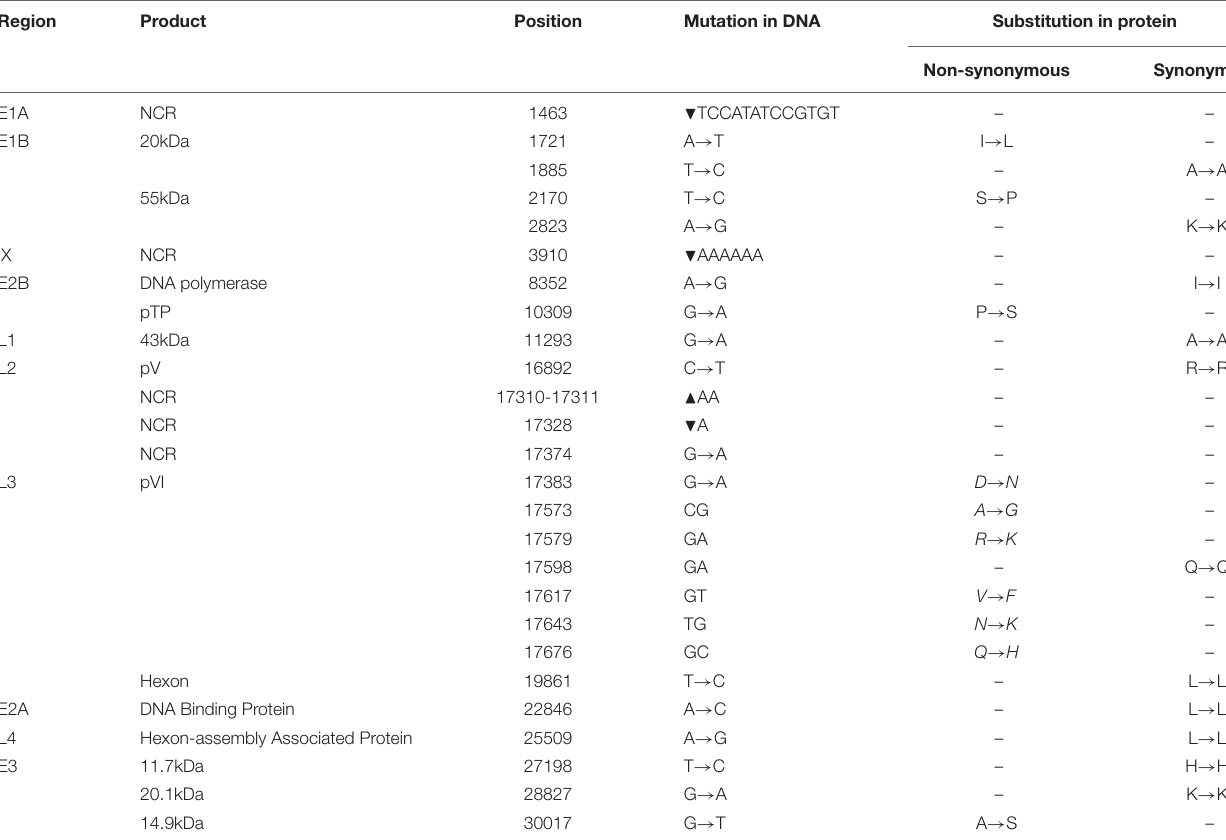
Nucleic acid and amino acid sequence changes are noted, along with their genome locations and coding consequences. The reference genome is HAdV-B55 strain QS-DLL. NCR, non-coding region; (cid:72) , insertion; (cid:78) , deletion; –, no change or not applicable. The major non-synonymous substitutions in pVI are italicized.